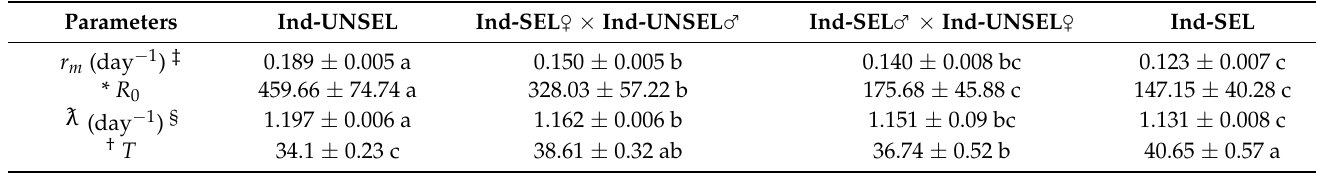
Table 7. Mean generation time, Net reproductive rate, intrinsic rate of increase, and finite rate of increase in S. frugiperda .